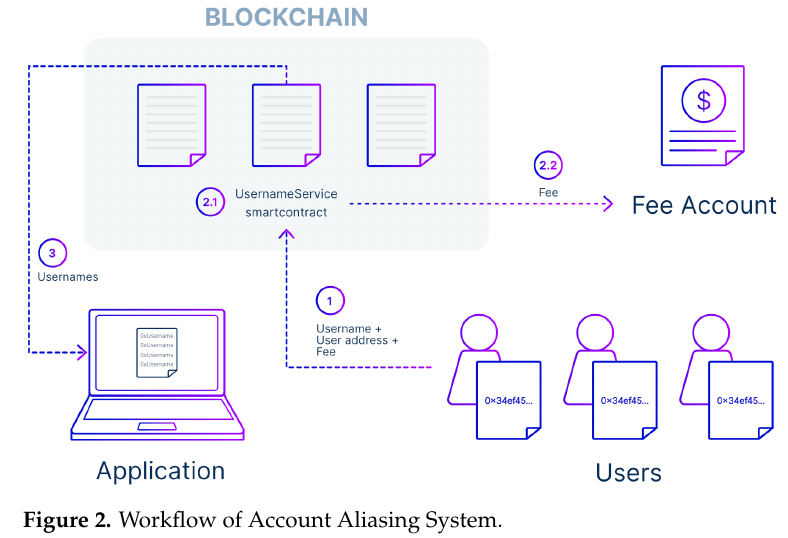
Figure 2. Workflow of Account Aliasing System.